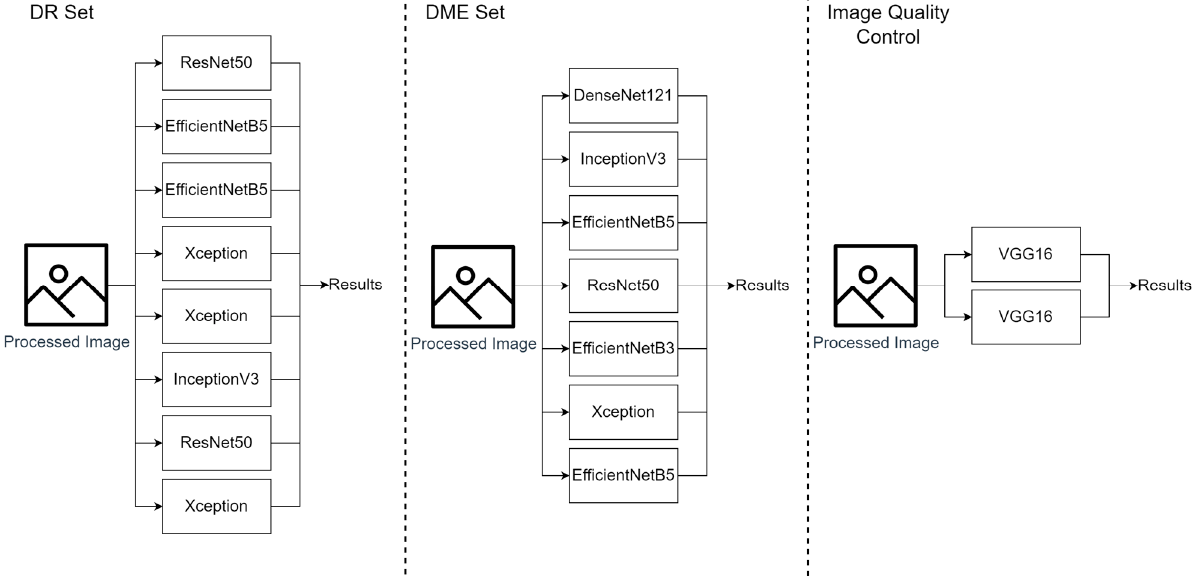
Figure A1. Detailed architecture of the ensembles.